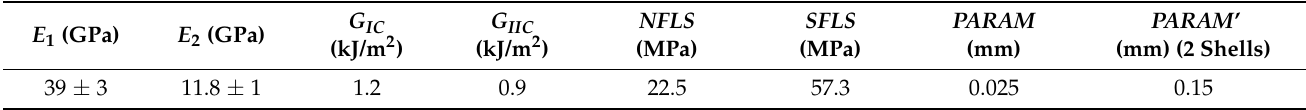
Table 1. Tiebreak input parameters